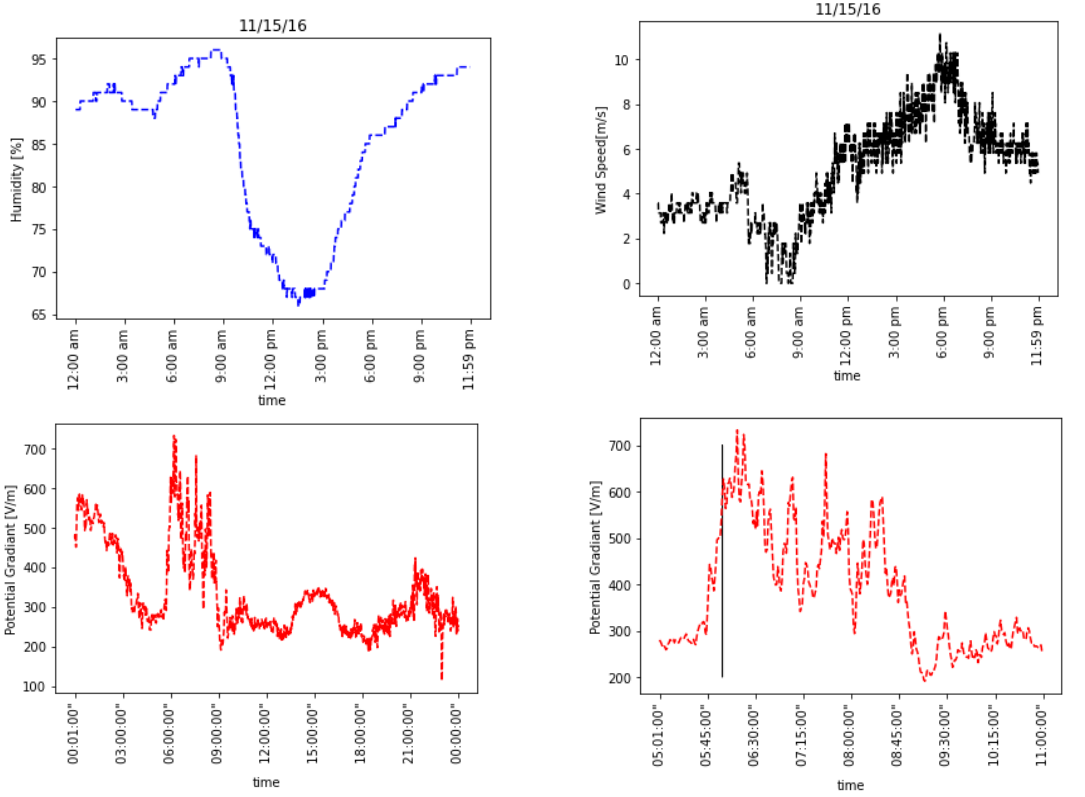
Figure 2. The 15 November 2016 fog case study. Hourly values of humidity ( top left ), wind speed ( top right ), full day PG ( bottom left ), and the hourly values of the PG between 5:00–11:00 local time ( bottom right ). The vertical black line marks the timing of sunrise at 6:07 LT.